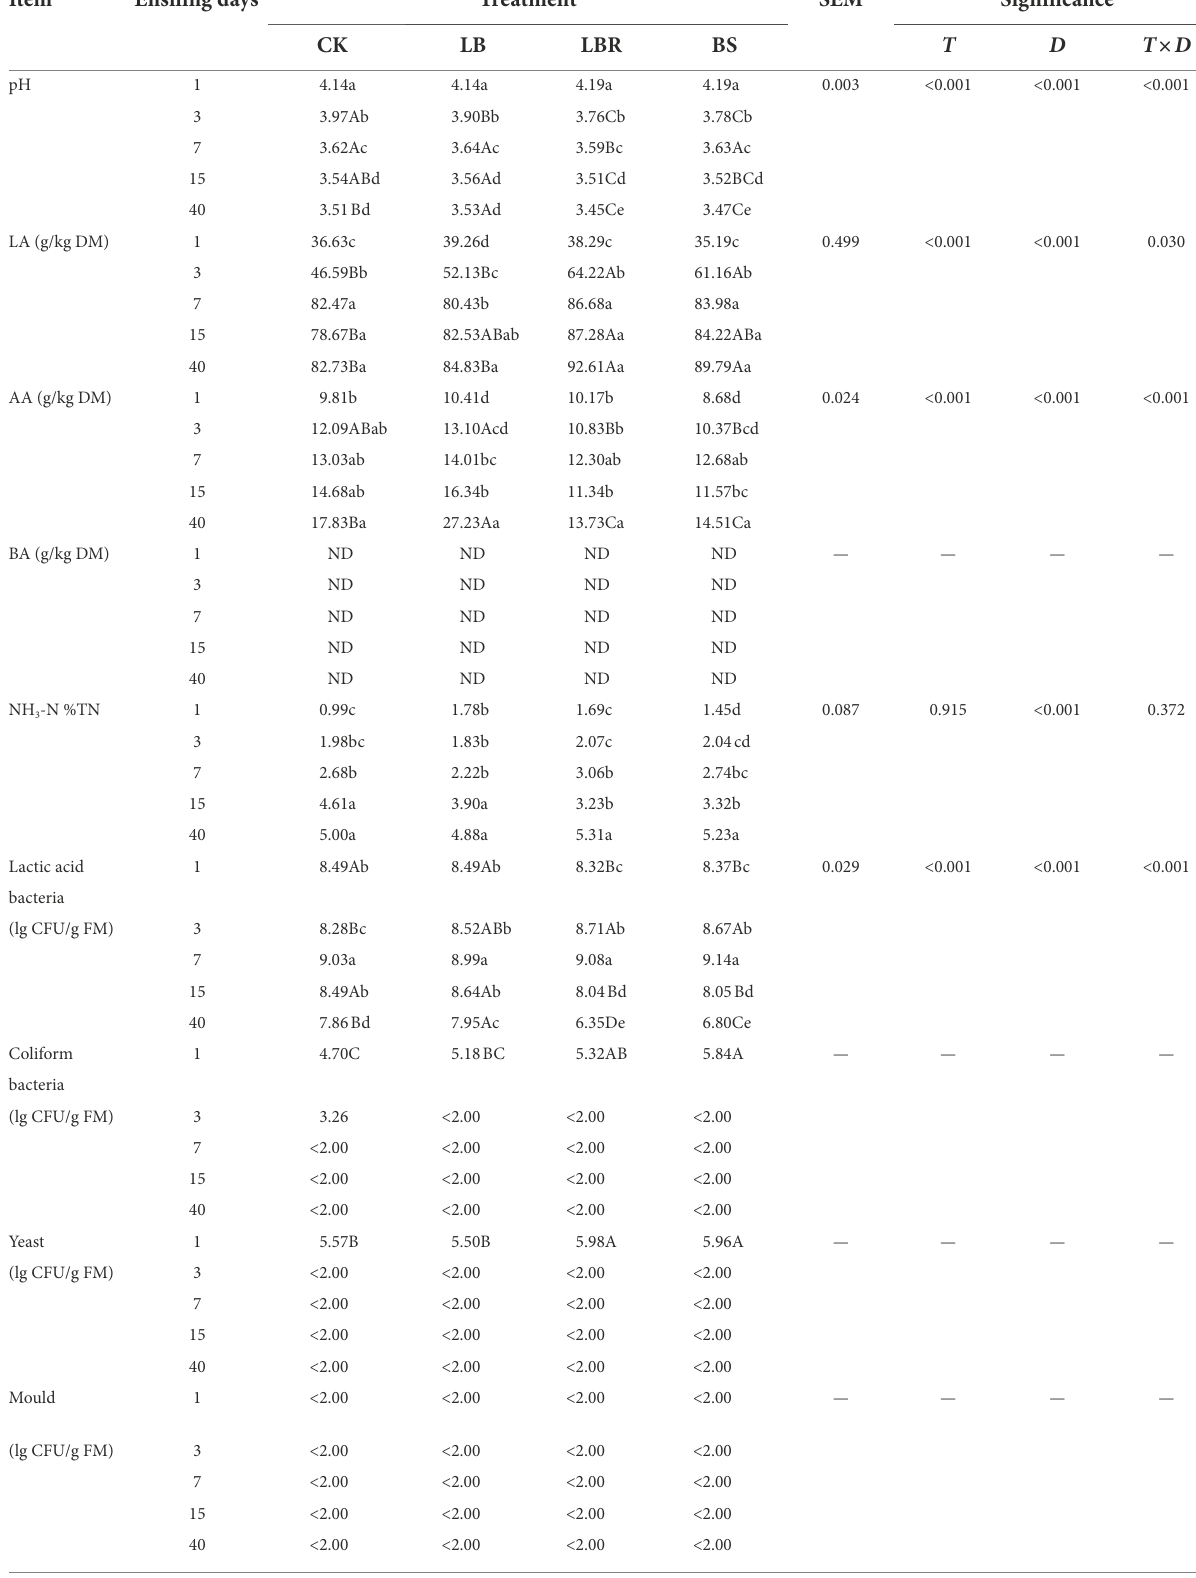
TABLE 2 Fermentation quality and microbial of sorghum-sudangrass silage. Item Ensiling